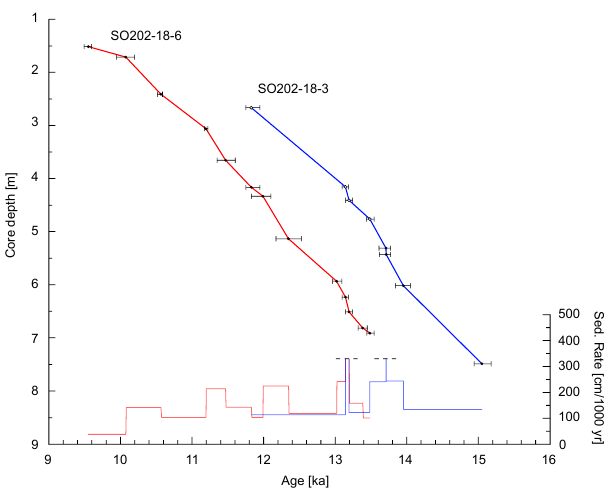
Figure 5. Age–depth relationship of cores SO202-18-3 (blue curve) and SO202-18-6 (red curve) based on use of constant reservoir ages of 700yr. Error bars show 1 σ ranges of 14 C results. White circles in blue curve show ages derived by core-to-core correlation. Light red and blue curves show sedimentation rates. Note the cut-off in the sedimentation rate at 325cm1000yr − 1 marked by a dashed line.